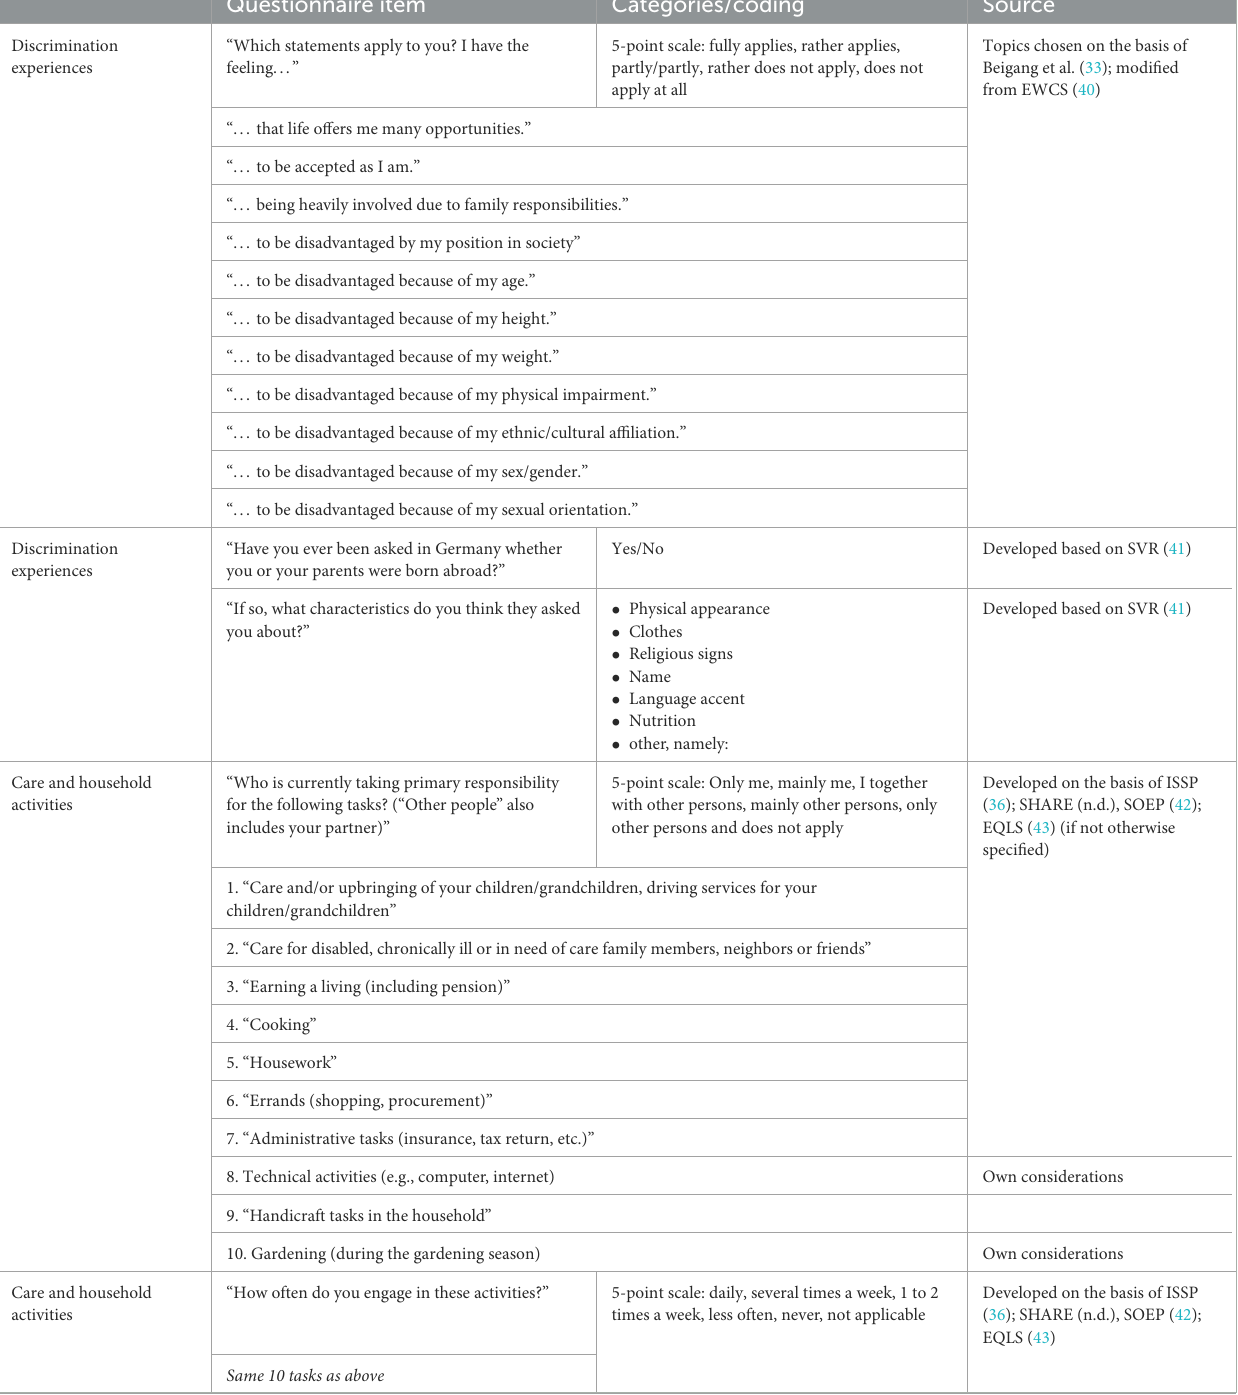
TABLE 2 Items contributing to explain structural sex/gender relations that (1) are intersectionally structured by further factors of social inequality: discrimination experiences and (2) represent gendered social positioning: care and household activities. Questionnaire item Categories/coding Source Discrimination